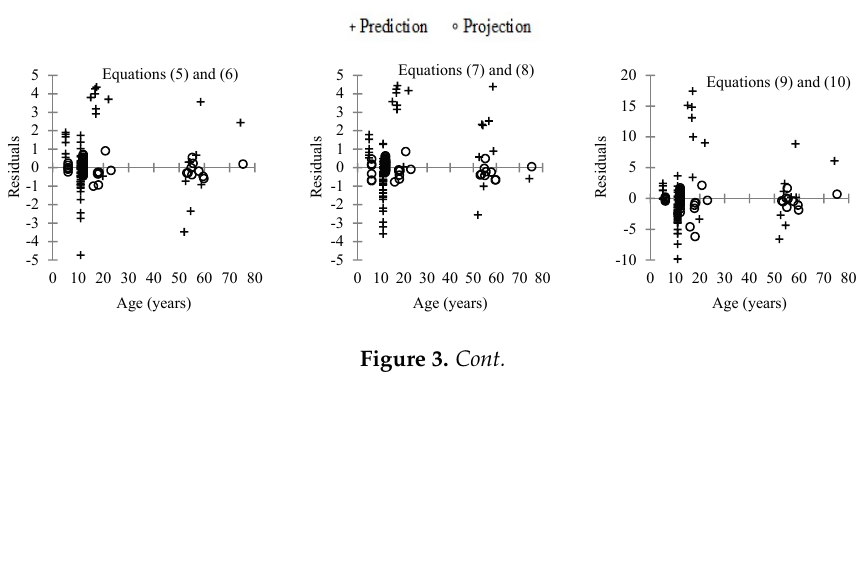
Figure 2. Families of growth curves for Pinus patula overlaid on the trajectories of the data observed in permanent sampling plots for the variables mean diameter at breast height, basal area and volume for different site qualities (SI = site index base age 40 years), and mortality with different initial densities ( LT 1 ) . ( DBH = diameter at breast height).